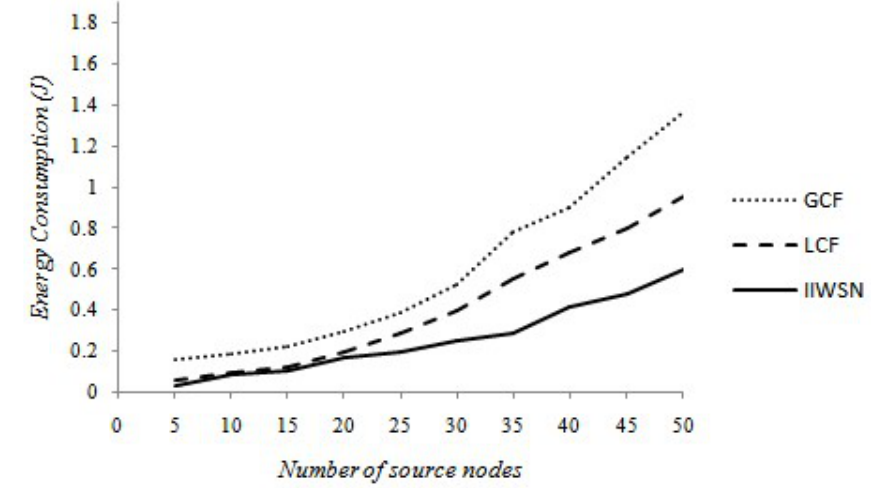
Figure 7. Comparison of energy consumption.